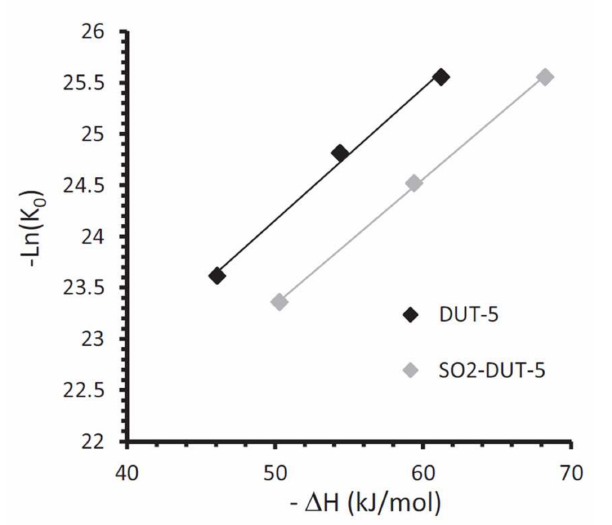
Figure 17. Compensation plot of linear alkanes (C5–C7) of SO 2 -DUT-5 and DUT-5. Reprinted with permission from [77]. Copyright (2015)